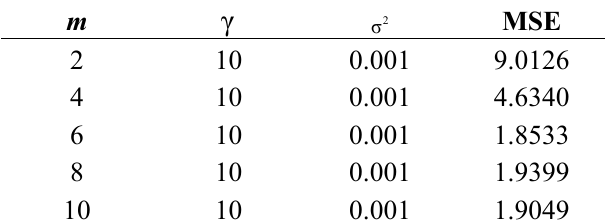
Table 1. The influence of m on prediction